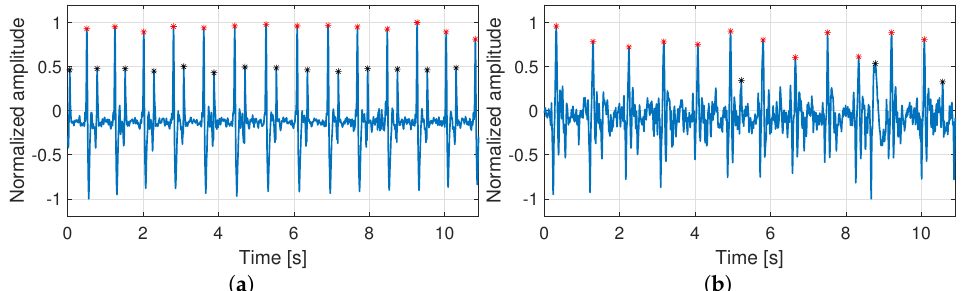
Figure 3. Examples of carotid sound recordings: ( a , b ) show recordings with high and low sig- nal quality, respectively; identified peaks for S1 and S2 candidates are plotted in red and black, respectively.